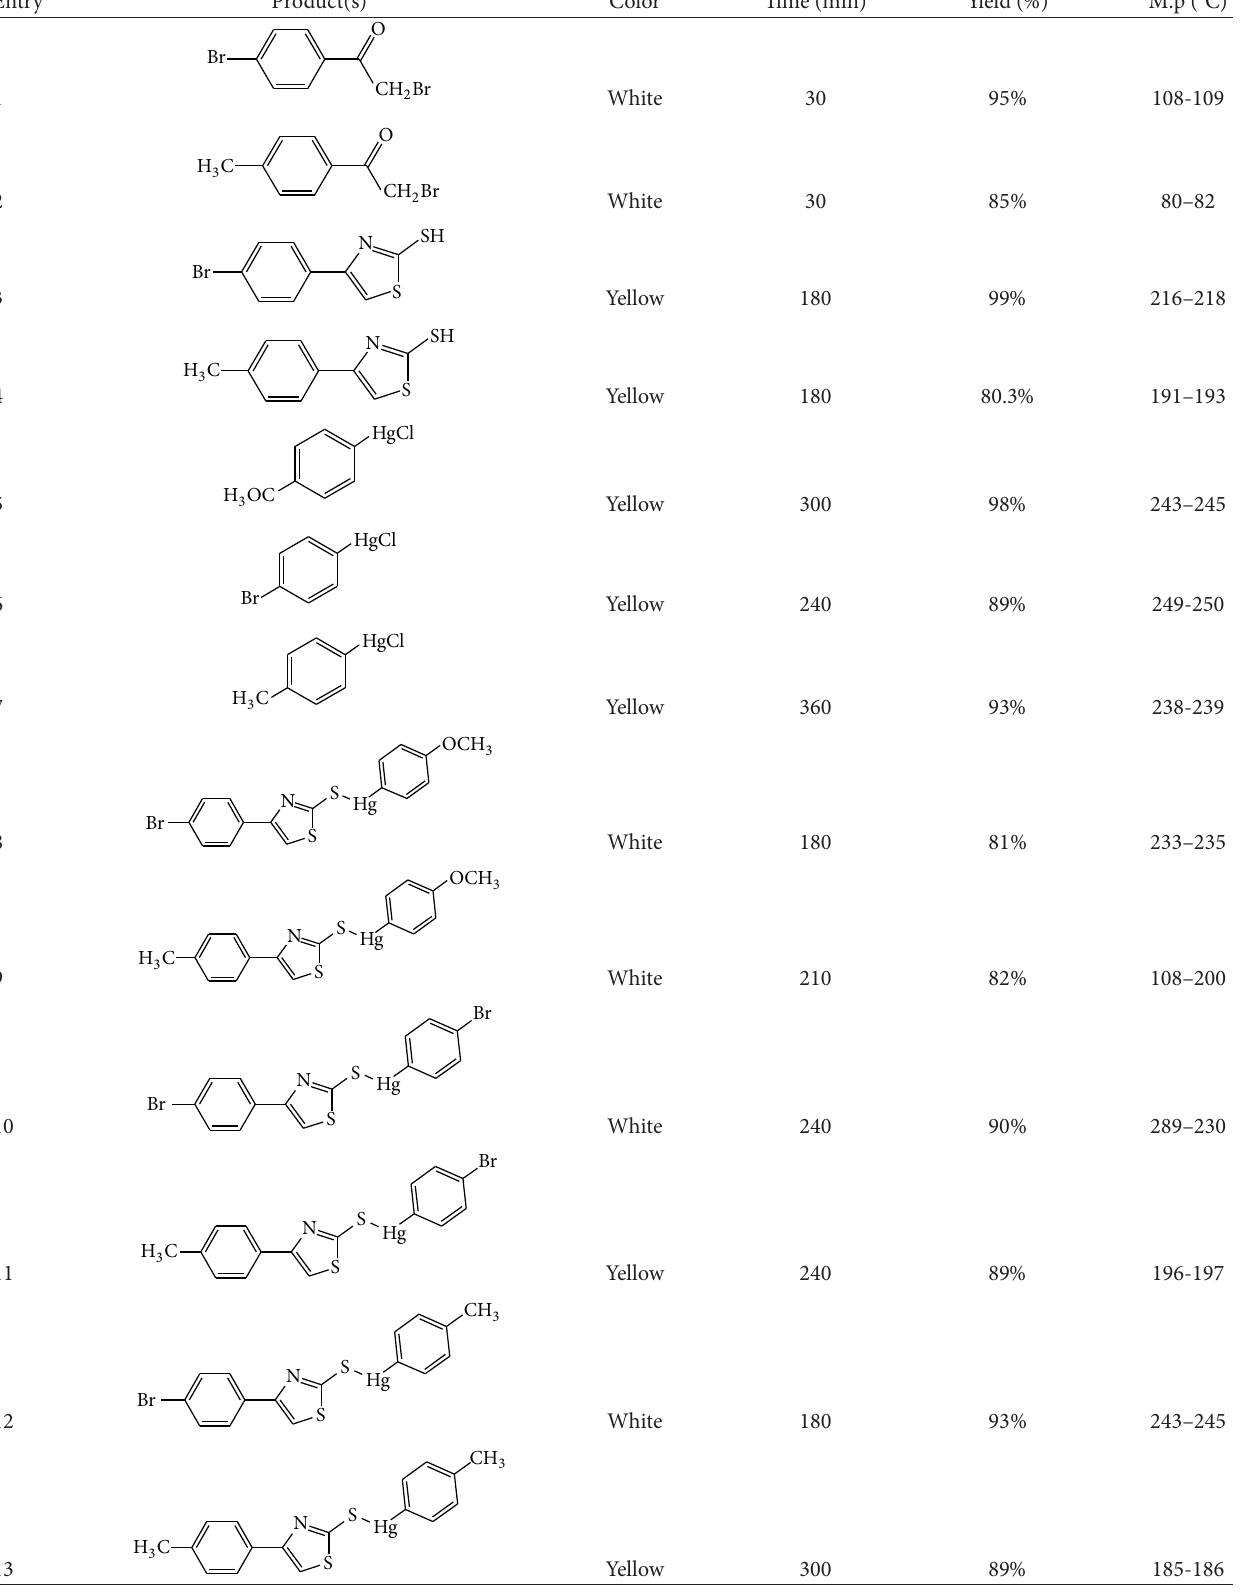
T 1: Yields and reaction conditions of the synthesized